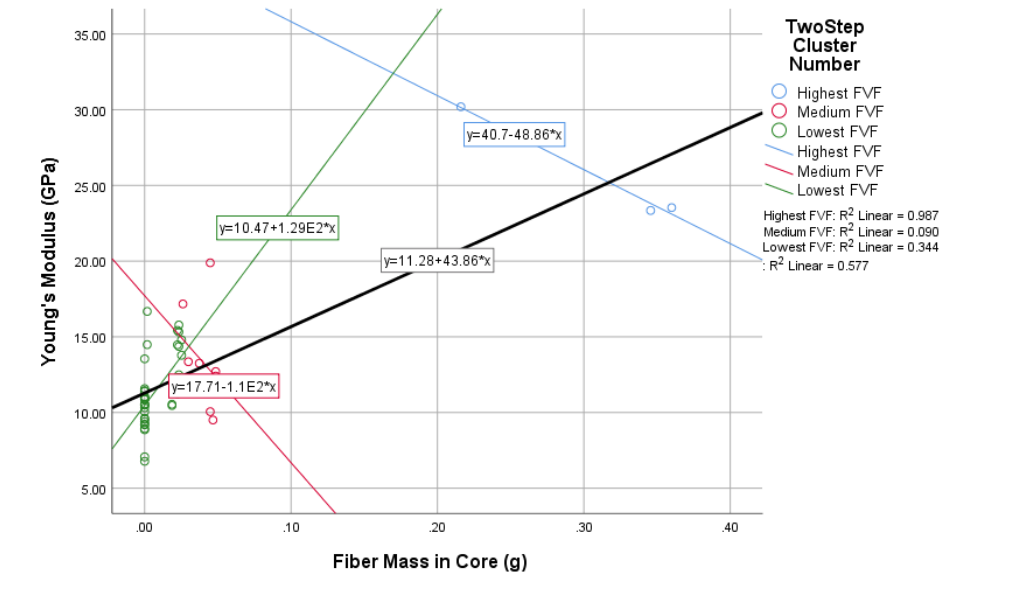
Figure 12. The relationship between fiber mass in the core and Young’s